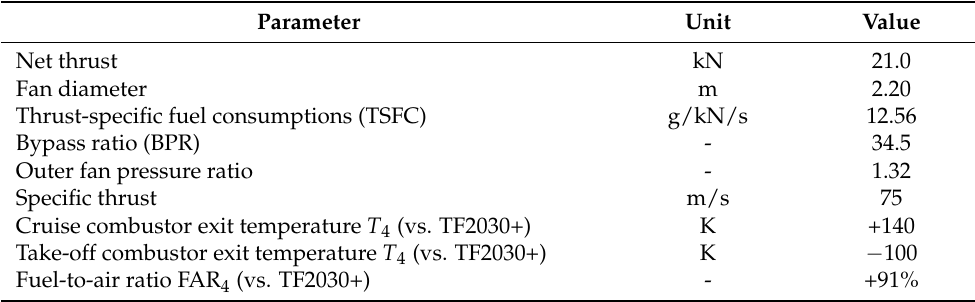
Table 1. Results summary of WET cycle at cruise conditions (35,000 ft, M0.78, ISA + 0 K). Parameter Unit Value Net thrust kN 21.0 Fan diameter m 2.20 g/kN/s 12.56 - 34.5